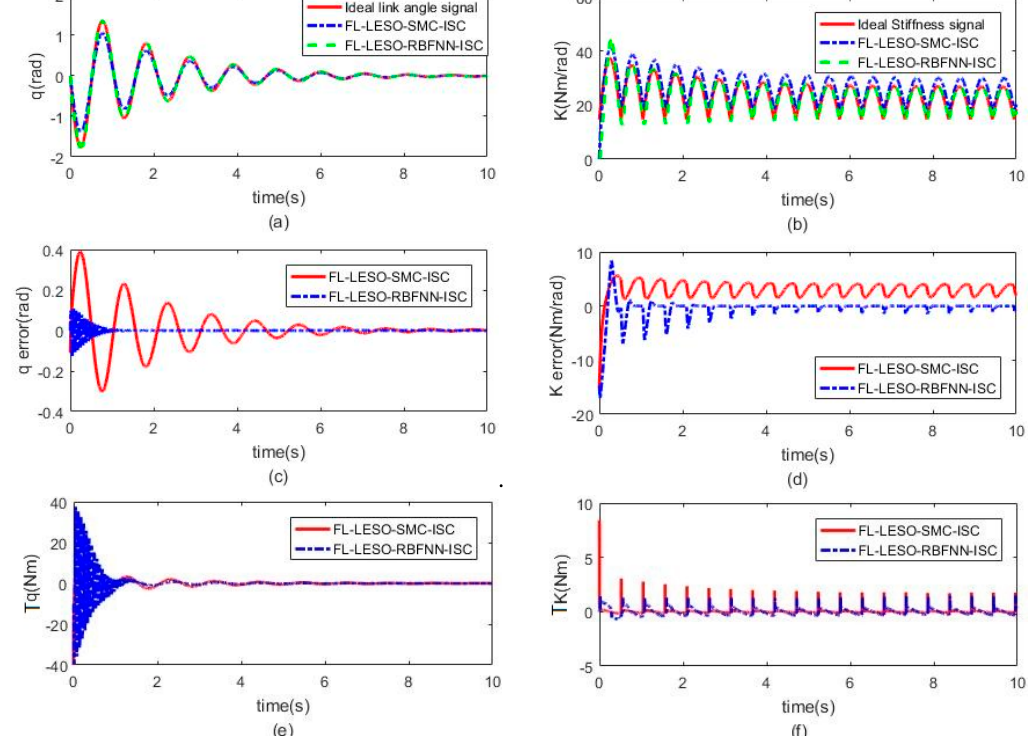
Figure 9. The experiment results. ( a ) VSJ angle tracking output response of two control algorithm. ( b ) VSJ stiffness tracking output response of two control algorithm. ( c ) VSJ angle tracking error VSJ angle tracking error of two control algorithm. ( d ) VSJ stiffness tracking error VSJ angle tracking error of two control algorithm. ( e ) VSJ angle tracking control torque of two control algorithm. ( f ) VSJ stiffness tracking control torque of two control algorithm.